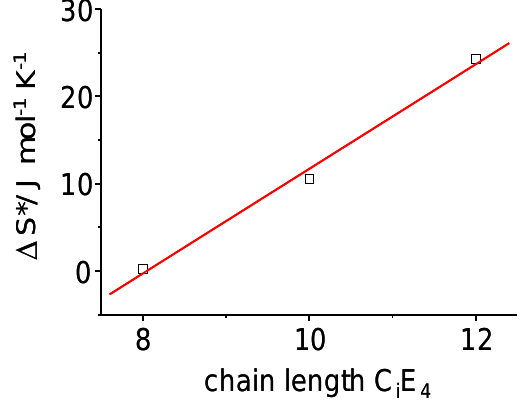
). A linear dependence of Δ S* on the chain 1/2 E has been i 4